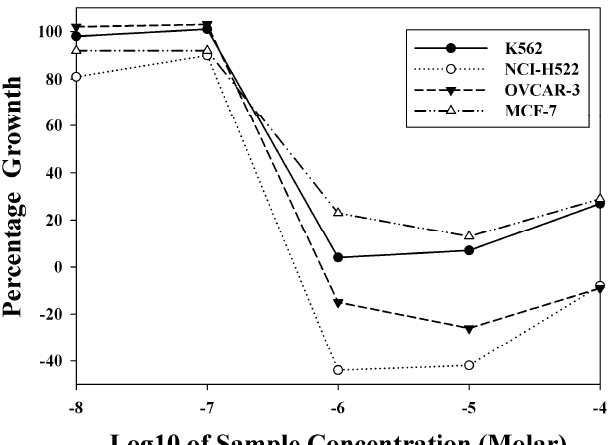
Figure 4. Dose-response curves of compound 1 against the sensitive cell